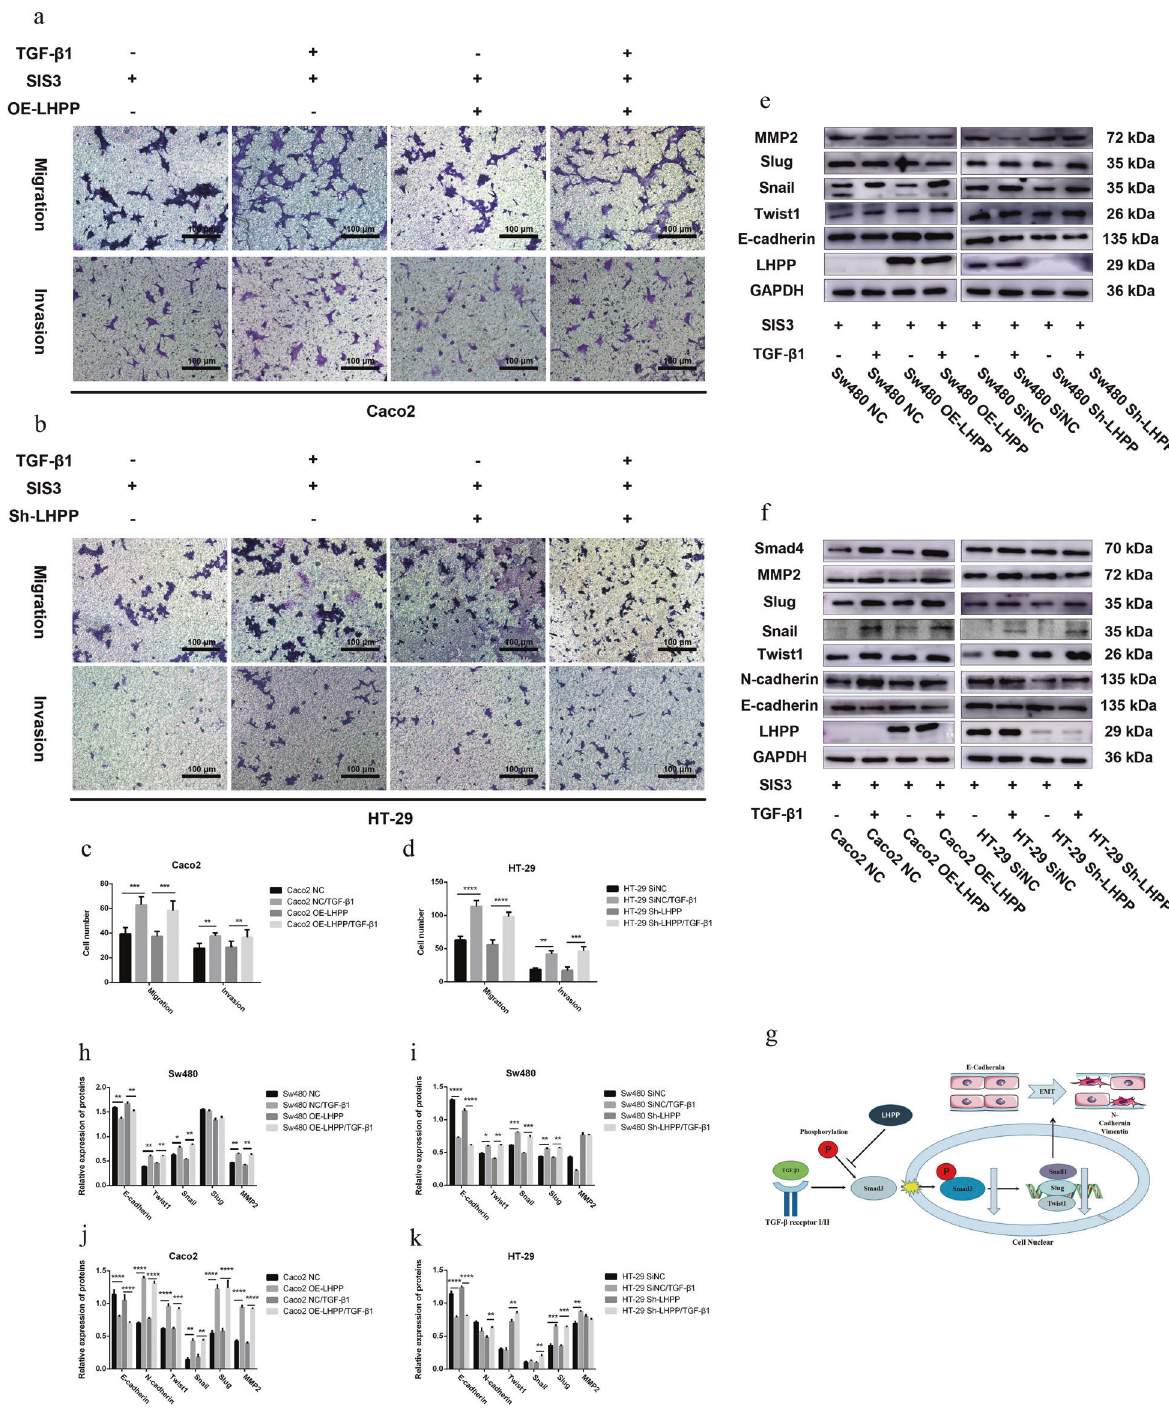
Fig. 7 In order to verify whether LHPP could inhibit migration and invasion abilities of colorectal cancer cells via inactivating phosphorylation of Smad3 speci fi cally or not. a , b The Transwell assay was used for evaluating the in fl uence of SIS3 (details described before) on TGF- β 1-mediated cell migration and invasion abilities (matrix gel 80 μ l, dilution 1:8, 8- μ m pore, scale bar, 100 μ m, ×100). c , d Quanti fi cation results were determined using the Graphpad Prism 6 software. Migrated and invasive cells were stained and counted in at least fi ve microscope fi elds. e , f Expression levels of EMT-related proteins in colorectal cancer cell lines. A signi fi cant difference could be observed not only in the overexpression group but also in the downexpression group with or without TGF- β 1 treatment. g Potential mechanism of LHPP in migration and invasion abilities of the colorectal cancer cell. h – k Relative expression levels of biomarkers were calculated using Image J and Graphpad Prism 6 software. * P < 0.05, ** P < 0.01, *** P < 0.001, **** P < 0.0001.